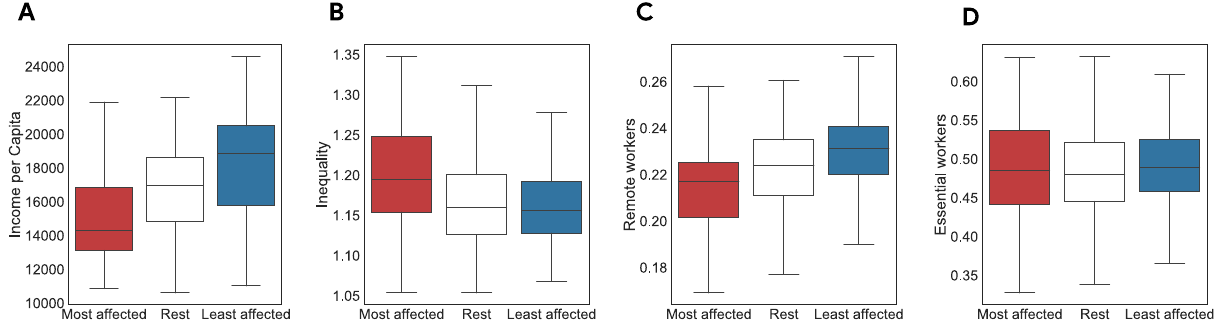
Figure 4. ( A – D ) Distributions of socioeconomic features for the most (red) and the least (blue) affected LLMs, and remaining ones (white), identified using lockdown variable and K = 30% . For variables in panels ( A – C ), the Kruskal–Wallis test to assess statistical differences between the distributions of the classes of LLMs is significant at a level α = 0.001 . For the variable in panel ( D ), it is not significant. According to the pairwise multiple comparison tests with Conover procedure and Bonferroni correction for p -values, distributions are statistically different at a level α = 0.01 in all cases for variables in panels ( A – C ), with the following exceptions: in panel ( B ), there is no significant difference between Rest and Least; in panel ( C ) the difference between Rest and Least is significant at a level α = 0.05